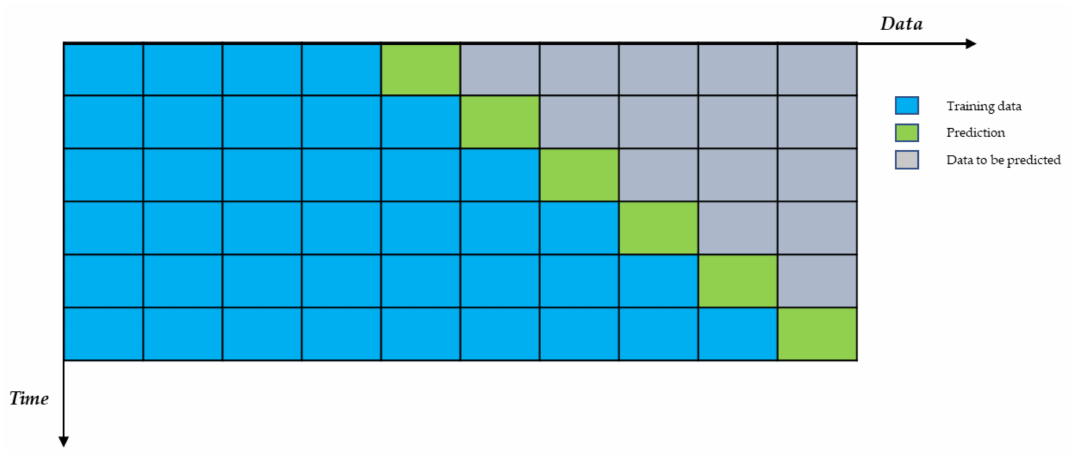
Figure 9. Graphical representation of walk-forward